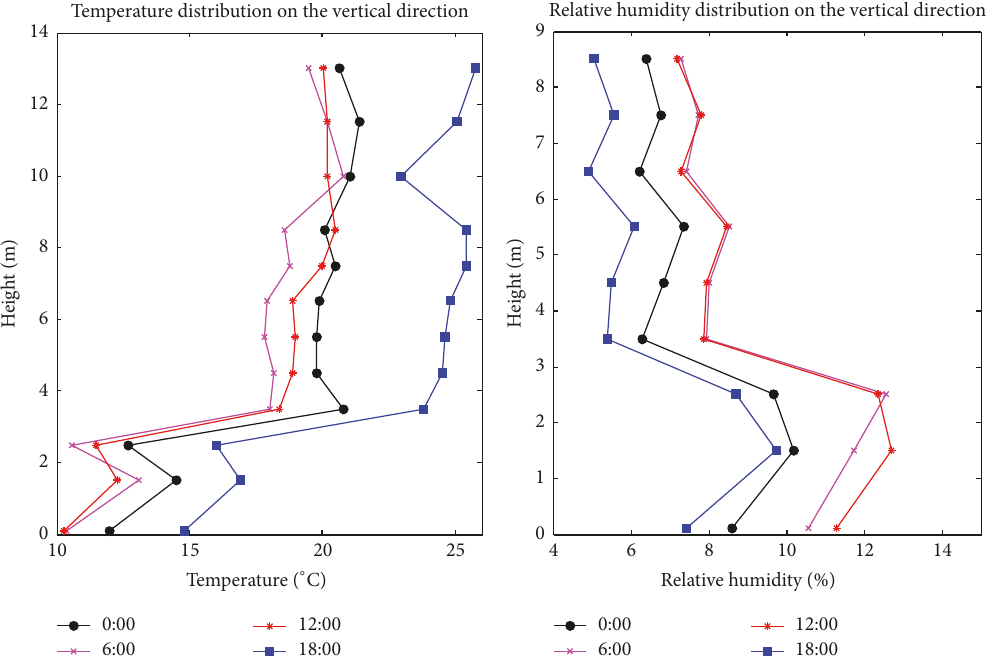
Figure 9: Distribution of temperature and humidity on the vertical